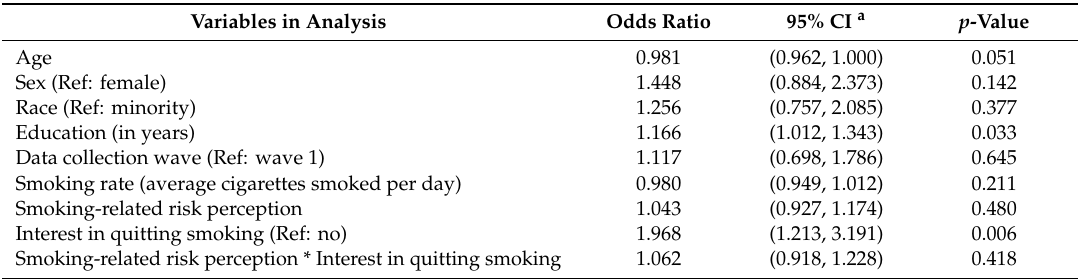
Table 2. Results of interest in lung cancer screening from ordinal regression